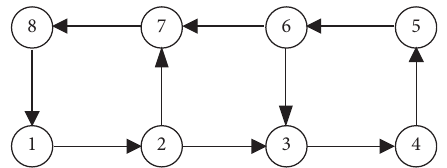
Figure 1: Directed interaction topology